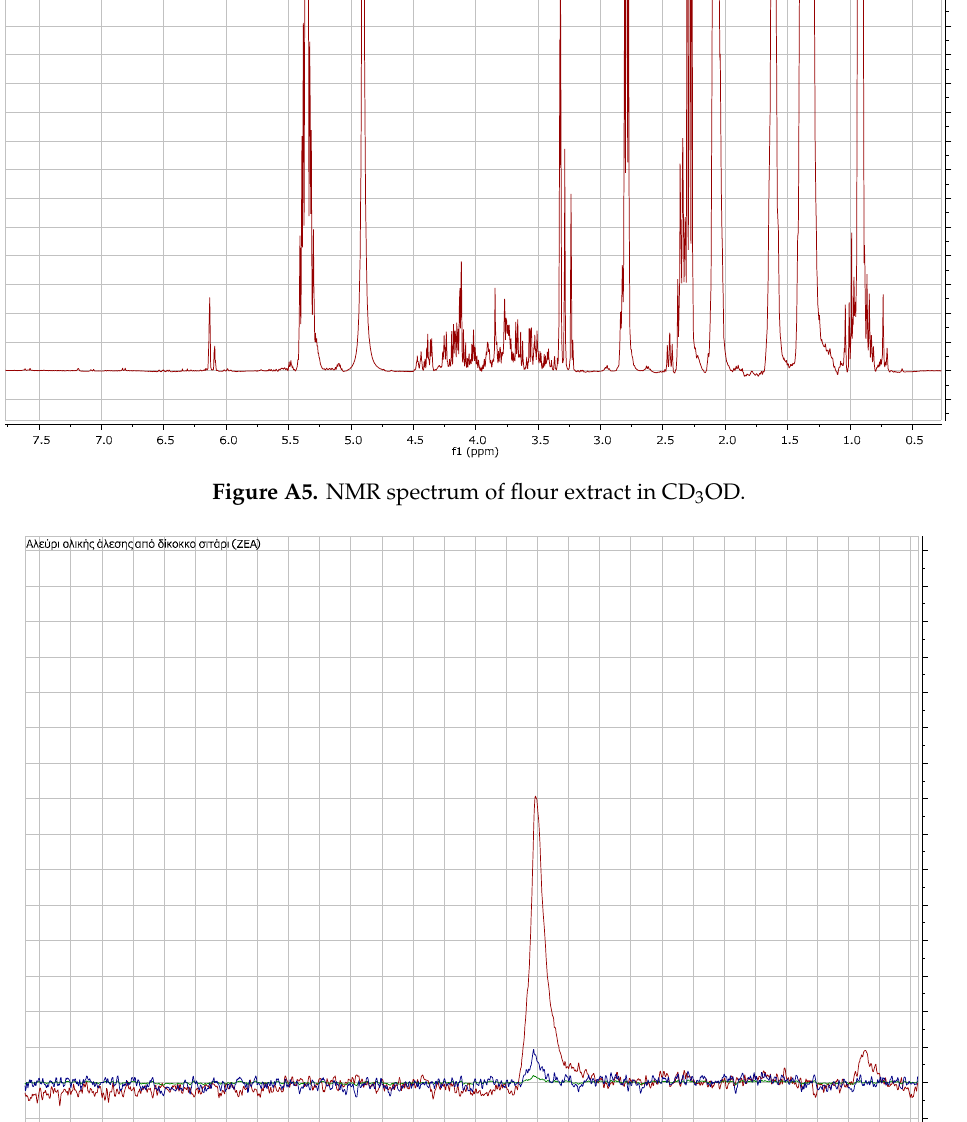
Figure A6. 1 H NMR spectrum of whole grain flour from Triticum dicoccum (ZEA ® ), after three Figure A6 . 1 Η NMR spectrum of whole grain flour from Triticum dicoccum ( ΖΕΑ ® ), after three successive extractions (red line 1st extraction, blue line 2nd extraction, green line 3rd successive extractions (red line 1 st extraction, blue line 2 nd extraction, green line 3 rd extraction).